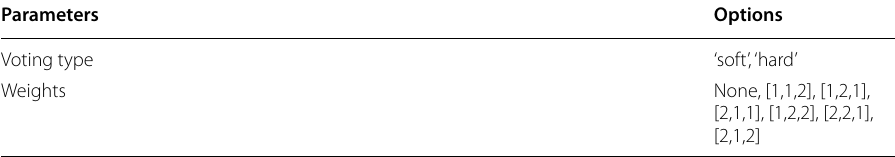
Table 6 Optimization settings of the most successful candidate ensemble models Parameters